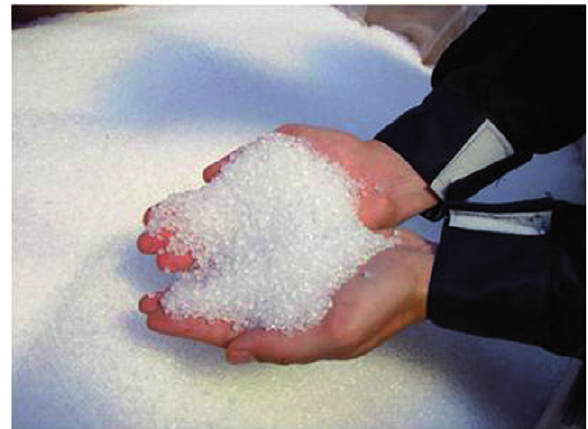
Figure 4 Polylactic acid